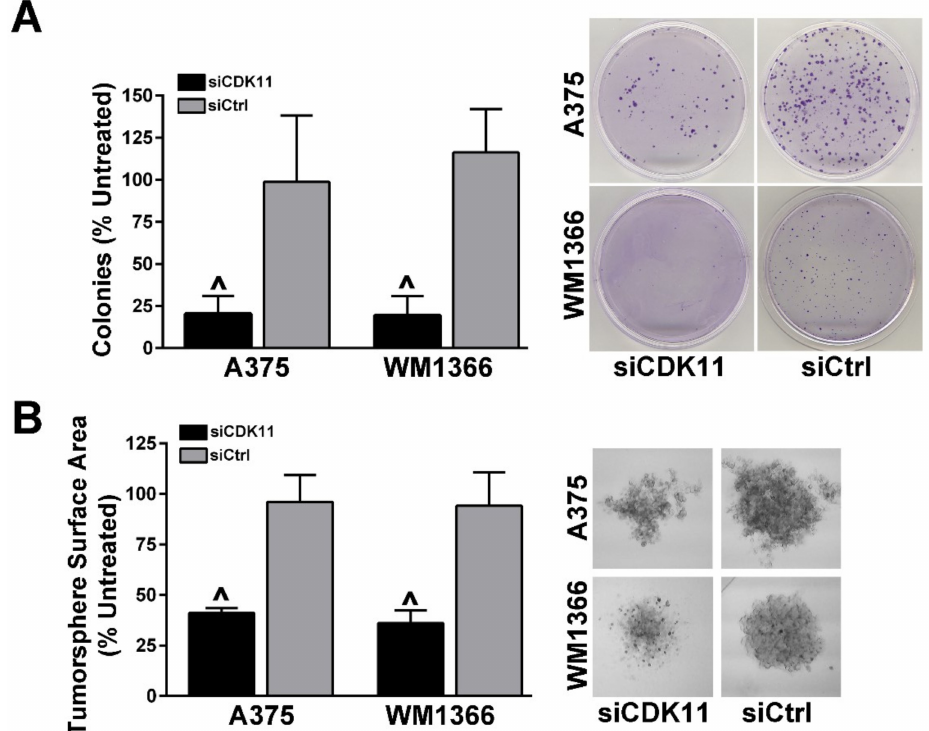
Figure 3. Down-regulation of CDK11 inhibits clonal survival and tumorsphere formation in melanoma cells. A375 and WM1366 cells were transfected with 30 nM siRNAs as indicated in the legends and as described in materials and methods. ( A ) For clonal survival analysis, cells were plated onto 35 mm plates 48 h post-transfection and colonies were stained and counted seven days after plating. Left: The chart presents means ± SD from three experiments with three replicate plates each. ˆ = p < 0.0001. Right: Representative crystal violet stained colonies on 35 mm plates. Cell lines are indicated to the left of images and siRNA transfections are indicated below plate images. ( B ) For tumorsphere formation, cells were plated into 96-well ultra-low attaching plates 48 h post-transfection and images captured 96 h after plating. Left: The chart presents means ± SD from three experiments with three areas each. ˆ = p < 0.0001. Right: Representative tumorsphere images. Cell lines are indicated to the left of images and siRNA transfections are indicated below plate